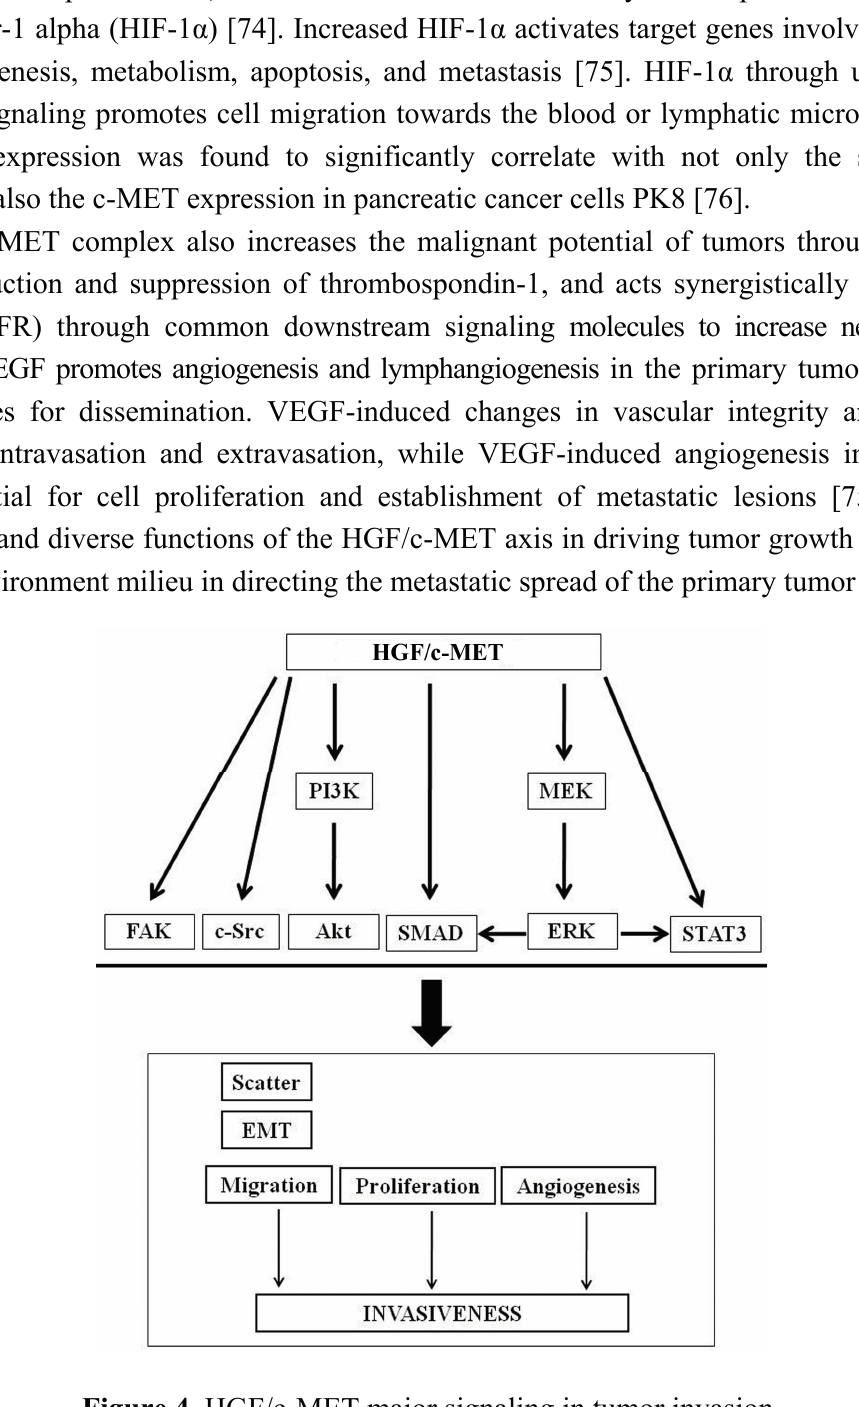
Figure 4. HGF/c-MET major signaling in tumor